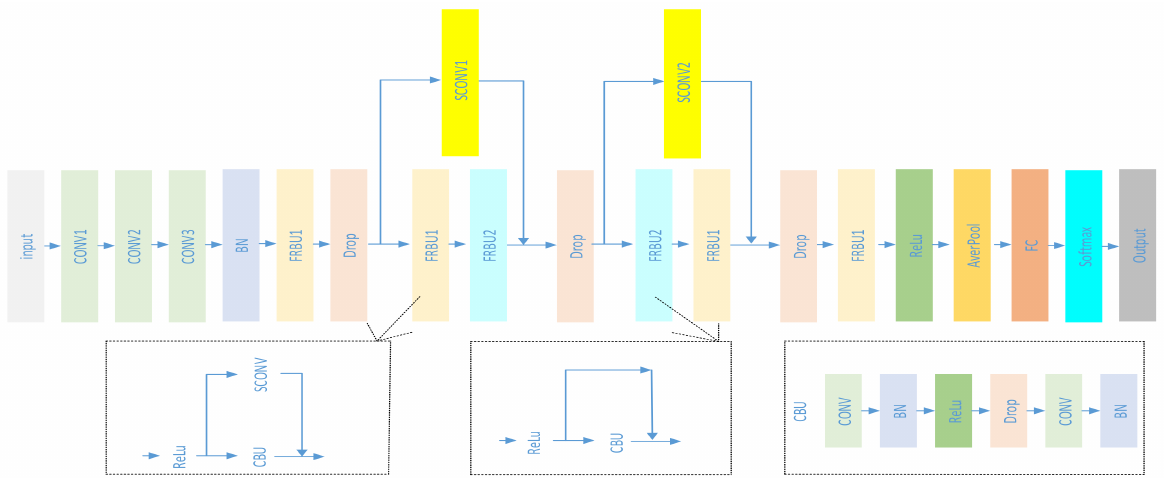
Figure 5. The proposed Deep Wide Residual